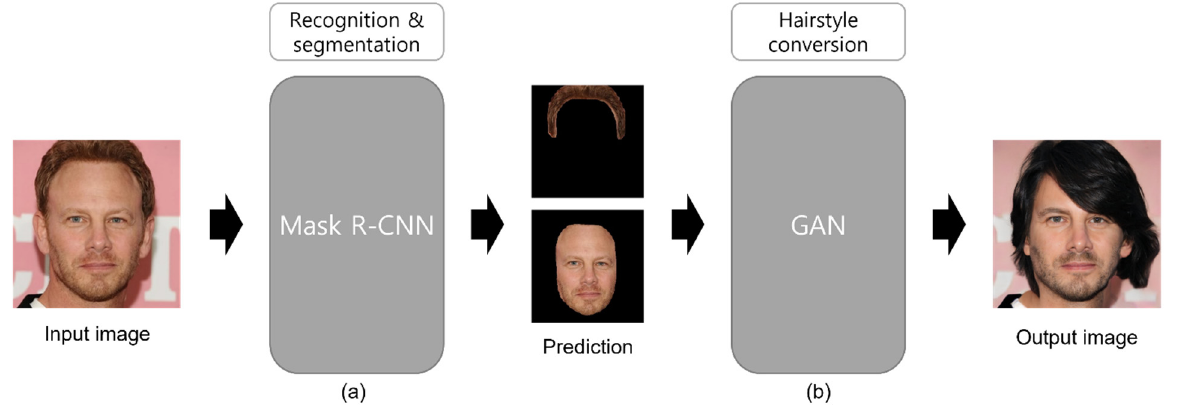
Figure 1. Overview of the structure of our proposed model, HSC-Net: ( a ) recognition and separation of hair and face in input image through Mask R-CNN, and ( b ) hairstyle conversion using GAN.